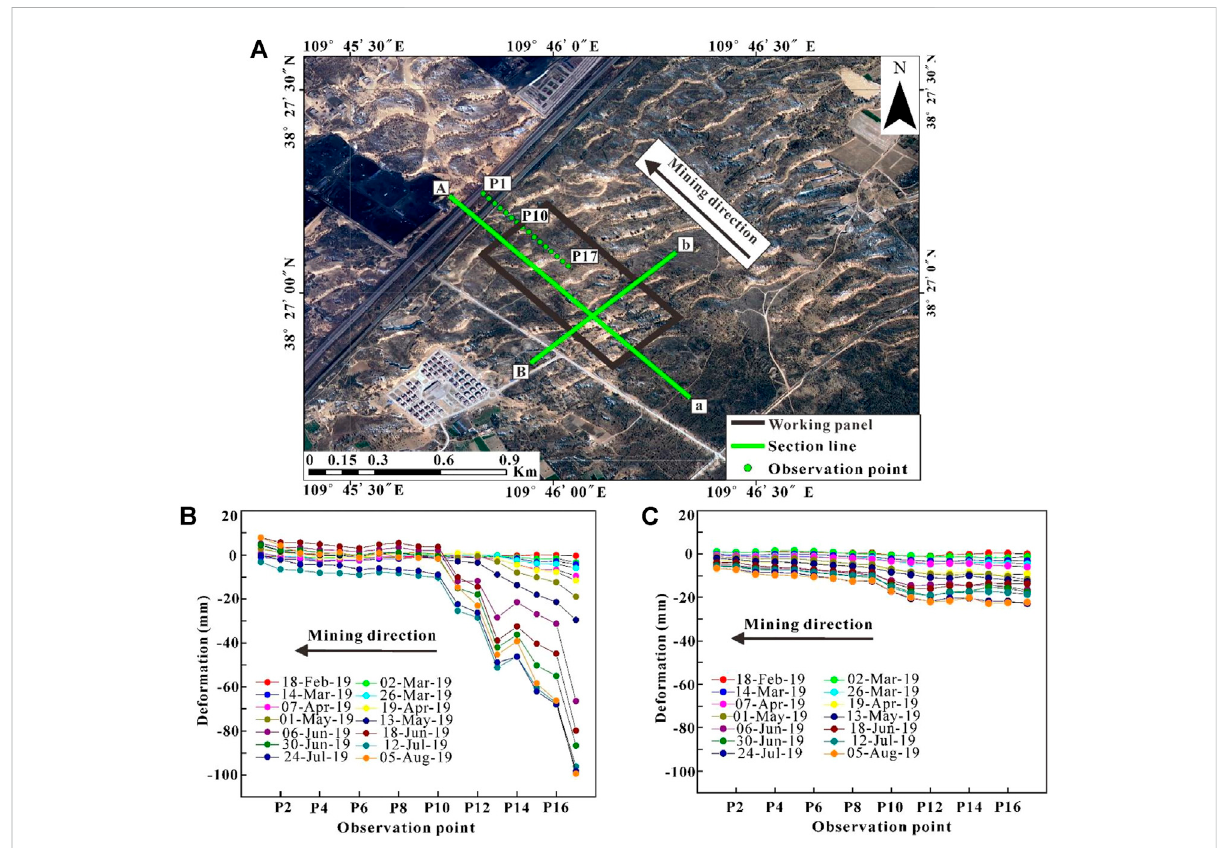
FIGURE 8 (A) GNSS points and pro fi le lines Aa and Bd arranged along the strike and dip direction of the working face (B) Time series deformation map of the continuous D-InSAR trend observation point, (C) Time series deformation map of the SBAS-InSAR towards observation